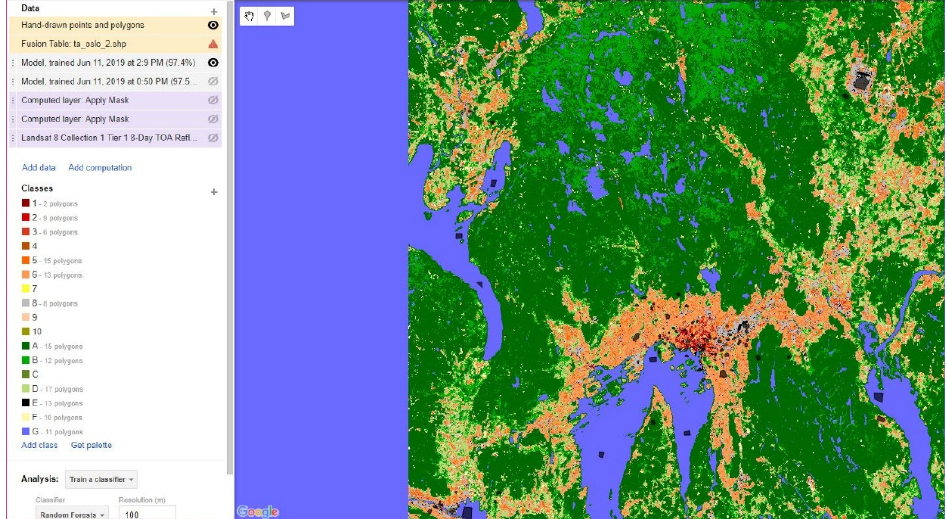
Figure 11. Completed LCZ of Oslo in Google Earth Engine (the blue background color is not related to any LCZ type and has the same color as LCZ G by coincidence).